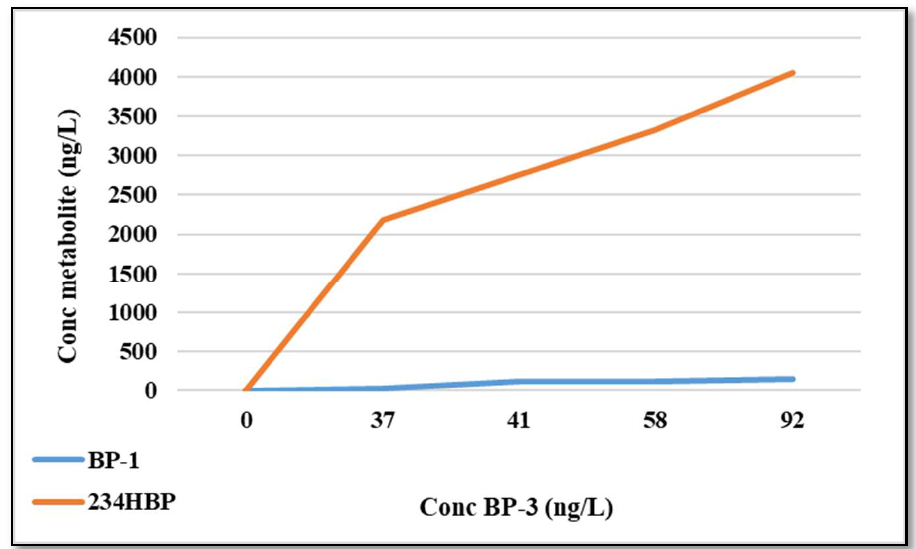
Figure 4. Variation in concentration of identified metabolites compared to the evolution of the BP-3 concentration, in water.